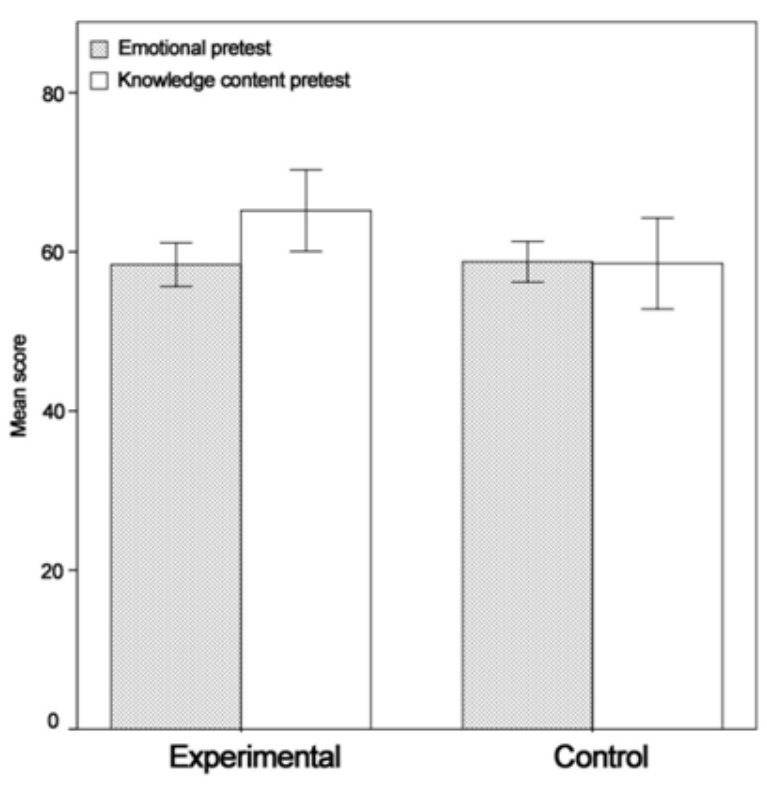
Figure 1. Mean score for emotional and knowledge content in pre- test evaluation for Experimental and Control group. Confidence interval for error bars of